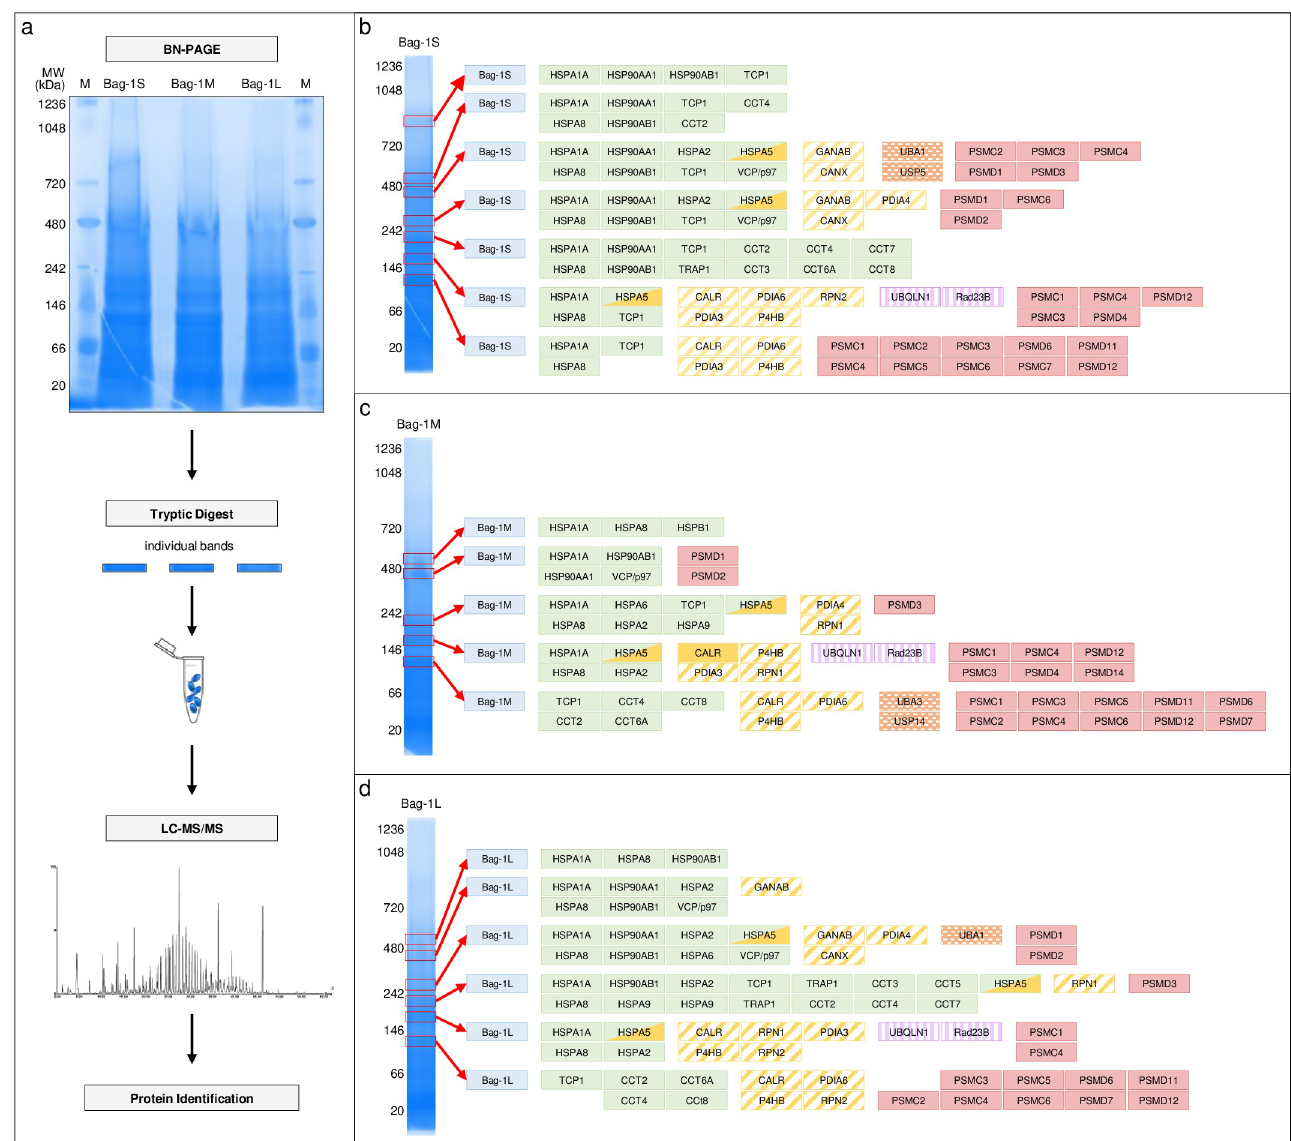
Fig 2. Components of isoform-specific Bag-1 complexes identified by BN PAGE/LC-MS/MS. a . Experimental workflow. Bag-1 immunoprecipitates were run on native gel. Individual bands in each lane were cut, trypsinized and the resulting peptides were analyzed by LC-MS/MS. M: Protein marker. b-d . Seven protein complexes were characterized for Bag-1S ( b ), five for Bag-1M ( c ), and six for Bag-1L ( d ). Identified proteins are color-coded as following: Blue: Bag-1, green: Chaperones, yellow: ER-resident proteins, orange: Ubiquitination elements, purple: Shuttling proteins, red: Proteasome subunits.